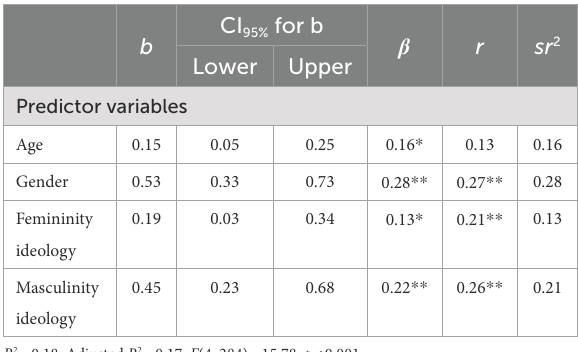
TABLE 6 Linear multiple regression predicting social media for appearance validation.